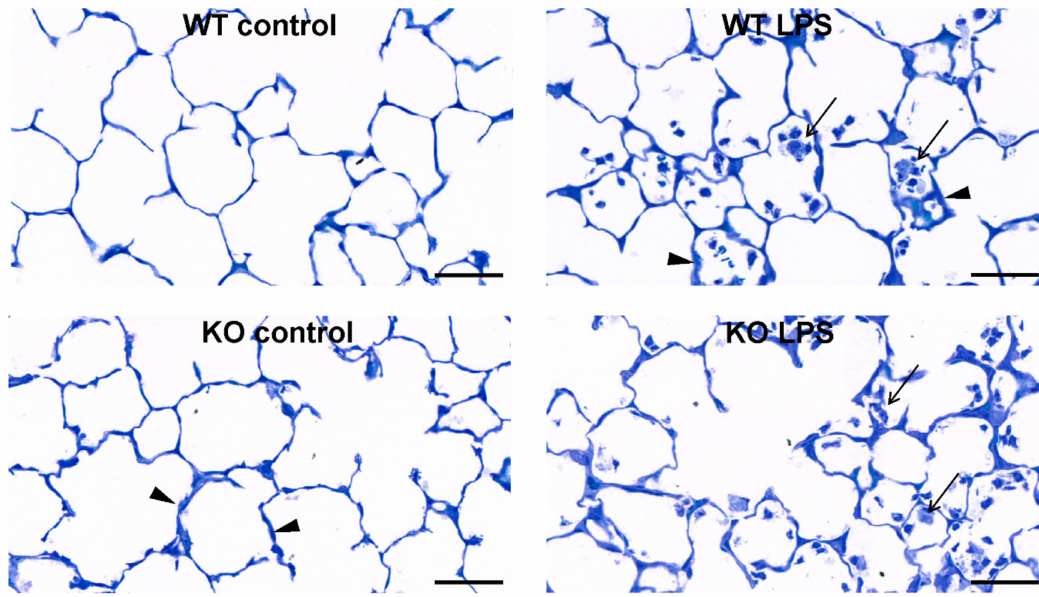
Figure 3. Representative light micrographs of toluidine blue stained lung parenchyma. The arrows indicate inflammatory cell infiltration, the arrow heads show septal thickening in the lung in the di ff erent experimental groups; scale bar = 50 µ